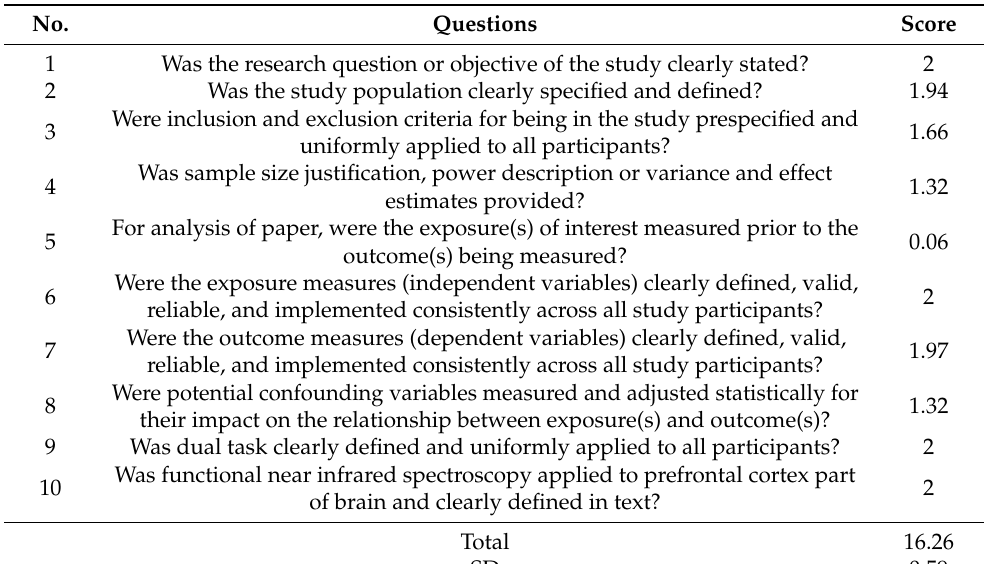
Table 3. Study Quality